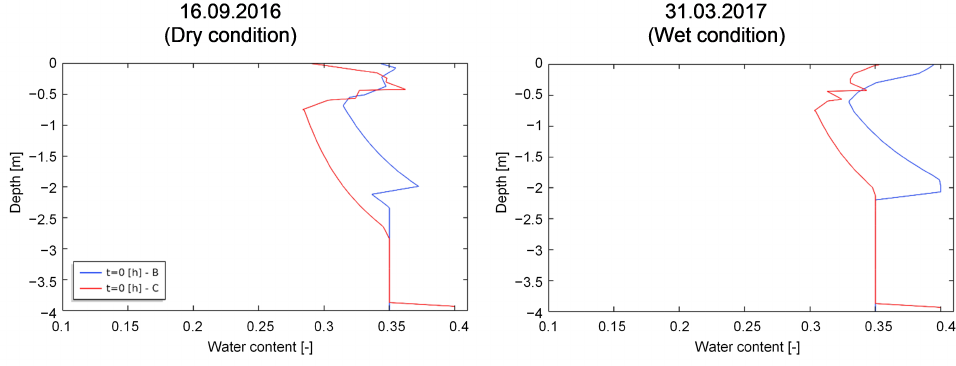
Figure 11. Initial conditions for water content for the event rainfall on 30 September 2016 and 31 March 2017 at the two most vulnerable locations B and C indicated in Figure